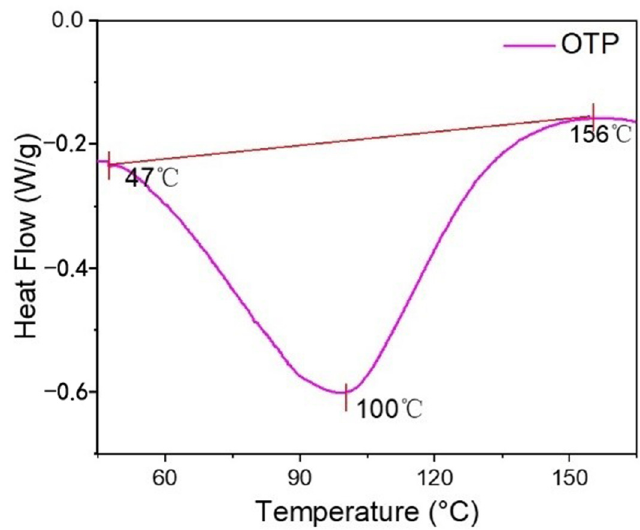
Figure 4. Differential scanning calorimetry (DSC) analysis of OTP.